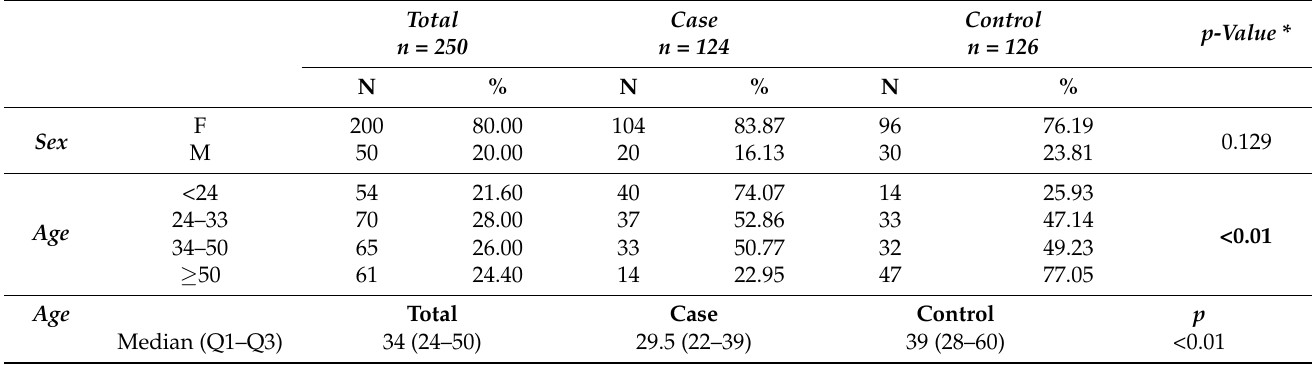
Table 1. Patient characteristics by